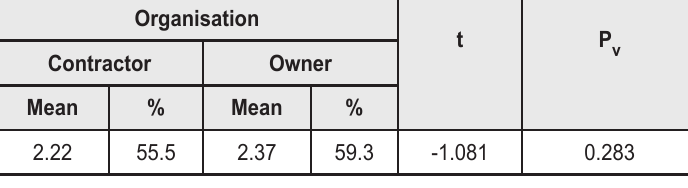
Table 4: Mean values for groups of project management tools